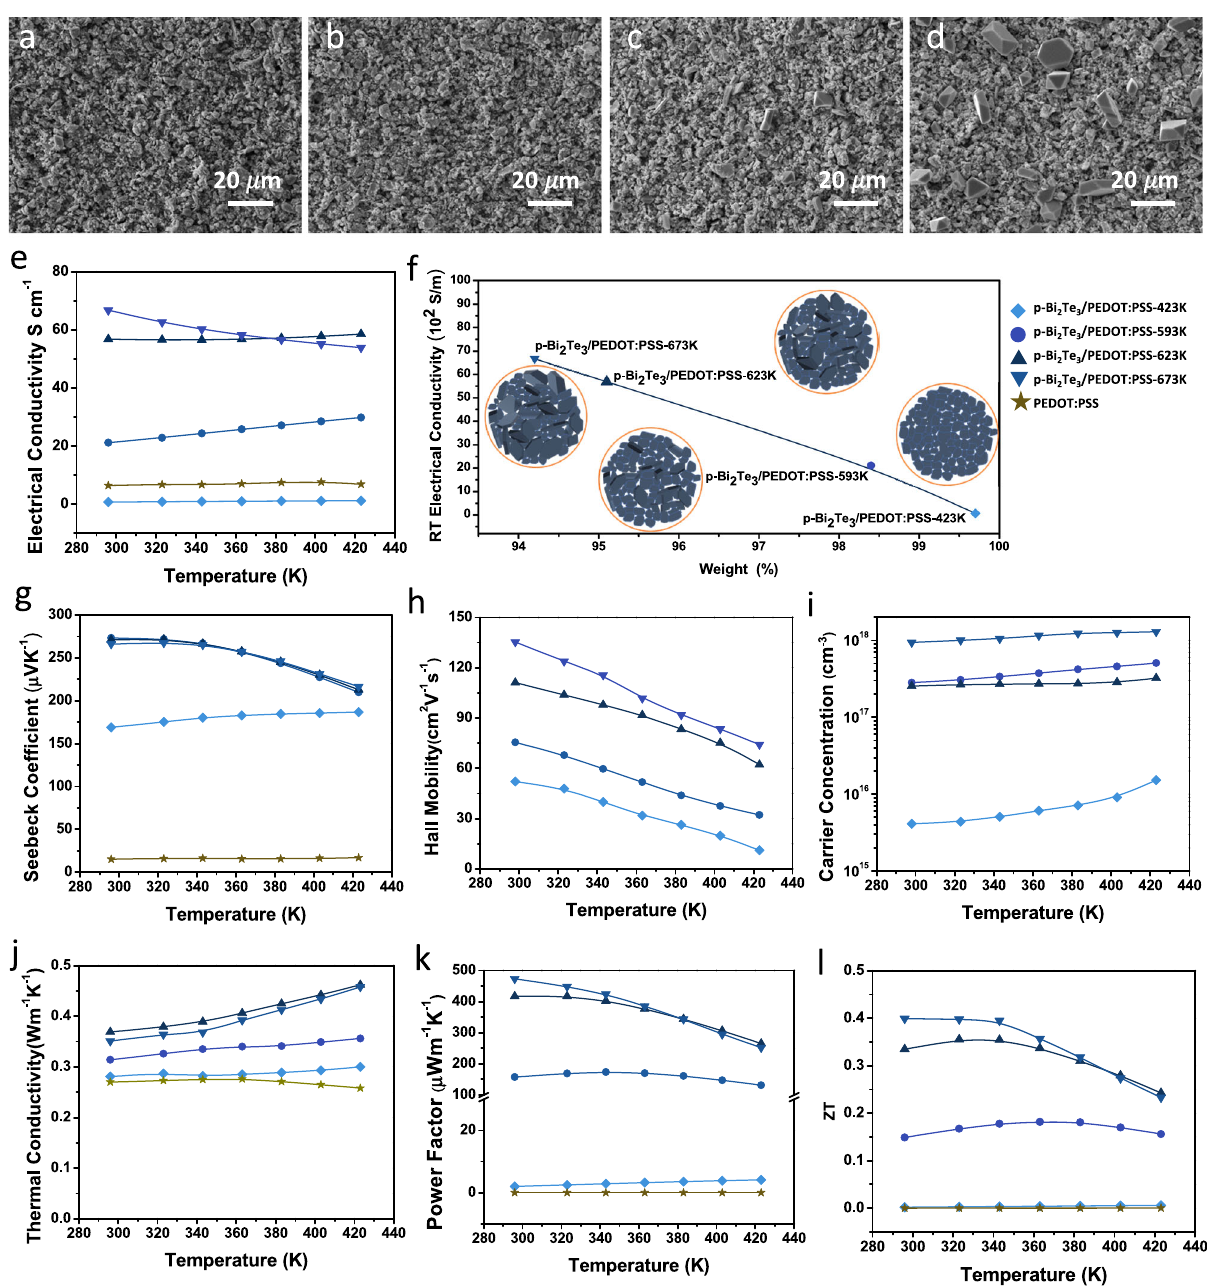
Fig. 4 Measurement results of p-Bi 2 Te 3 /PEDOT:PSS composites and pure PEDOT:PSS samples. a – d Top-view SEM images of p-Bi 2 Te 3 /PEDOT:PSS samples annealed at 423, 593, 623, and 673 K, respectively. e Measured temperature-dependent electrical conductivity of p-Bi 2 Te 3 /PEDOT:PSS and PEDOT:PSS, respectively. f Measured room temperature electrical conductivity of p-Bi 2 Te 3 /PEDOT:PSS with the weight variance under annealing, respectively. Measured temperature-dependent. g Seebeck coef fi cient of p-Bi 2 Te 3 /PEDOT:PSS samples and PEDOT:PSS, respectively. Temperature- dependent h Hall mobility, and i carrier concentration of p-Bi 2 Te 3 /PEDOT:PSS samples j thermal conductivity, k power factor, l fi gure of merit of p-Bi 2 Te 3 / PEDOT:PSS and PEDOT:PSS,